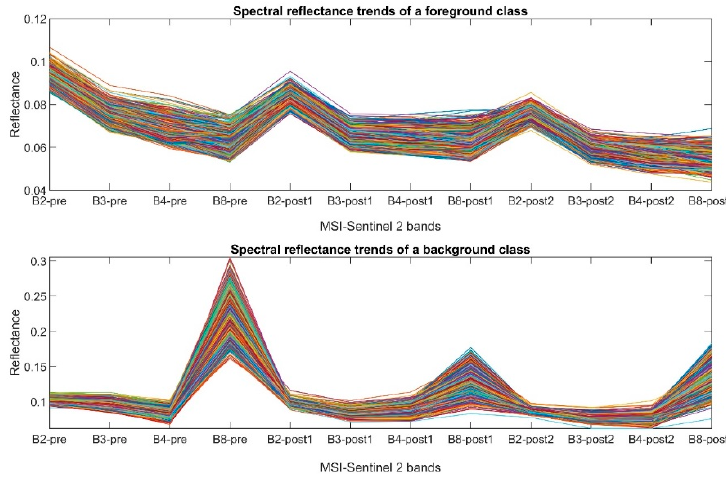
Figure 2. Difference between background (BG) and foreground (FG) pixels spectral reflectance trends over pre- and post- MSI Sentinel-2 data. Trends of pixels belonging to a FG class (up) and trends of the pixels belonging to a BG class (down) are shown. Different colored lines correspond to the pixels belonging to the FG class (up) and BG class (down).